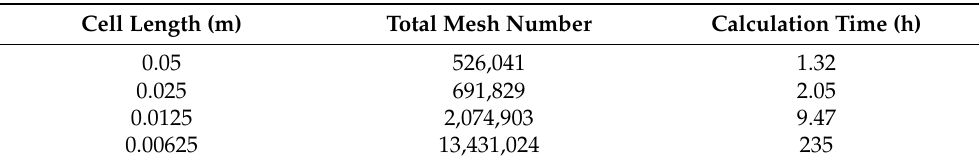
Table 2. Mesh sensitivity testing of the main calculation zone (using a computer with a double Inter Xeon Gold 5218R processor (2.1 GHz and 40 M cache) CPU).